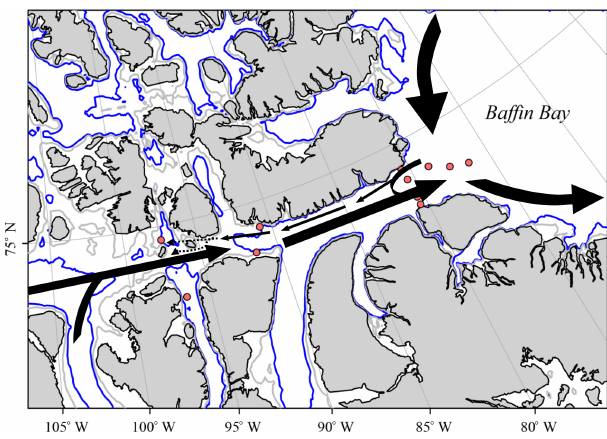
Figure 14. Sketch of the proposed surface flow pattern as identified in the current study, where dotted lines indicate reduced certainty of